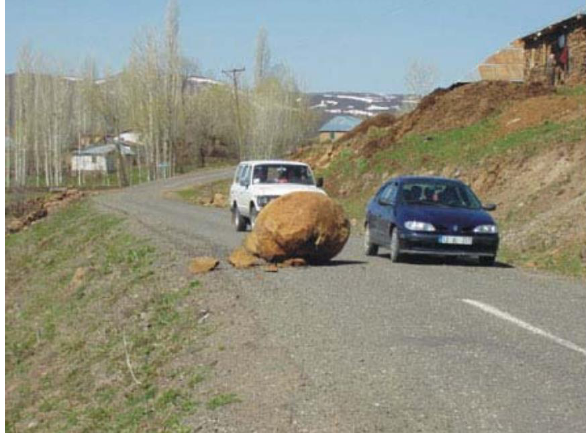
Figure 3. An example to rockfall from Bingol, Turkey, occurred after May 1 st , 2003 earthquake (MTA, 2003).